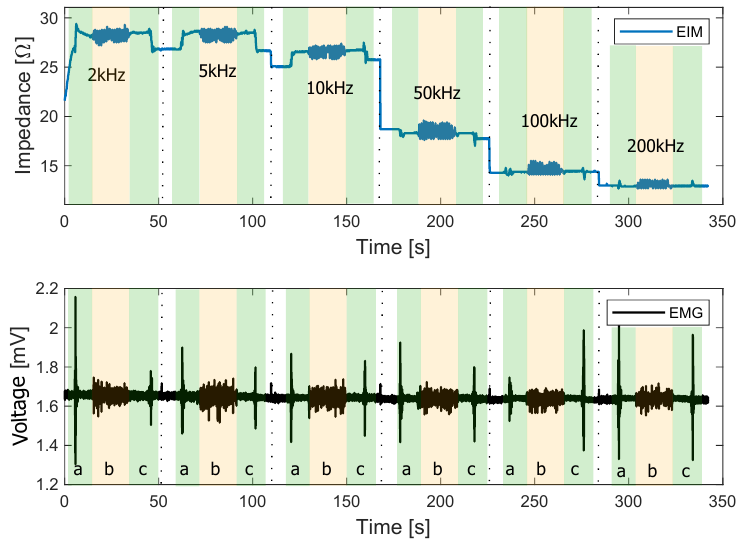
Figure 17. EIM and EMG signals over time at different frequencies during the sit-to-stand and walking phase. a: Sit-to-stand, b: walking, c: